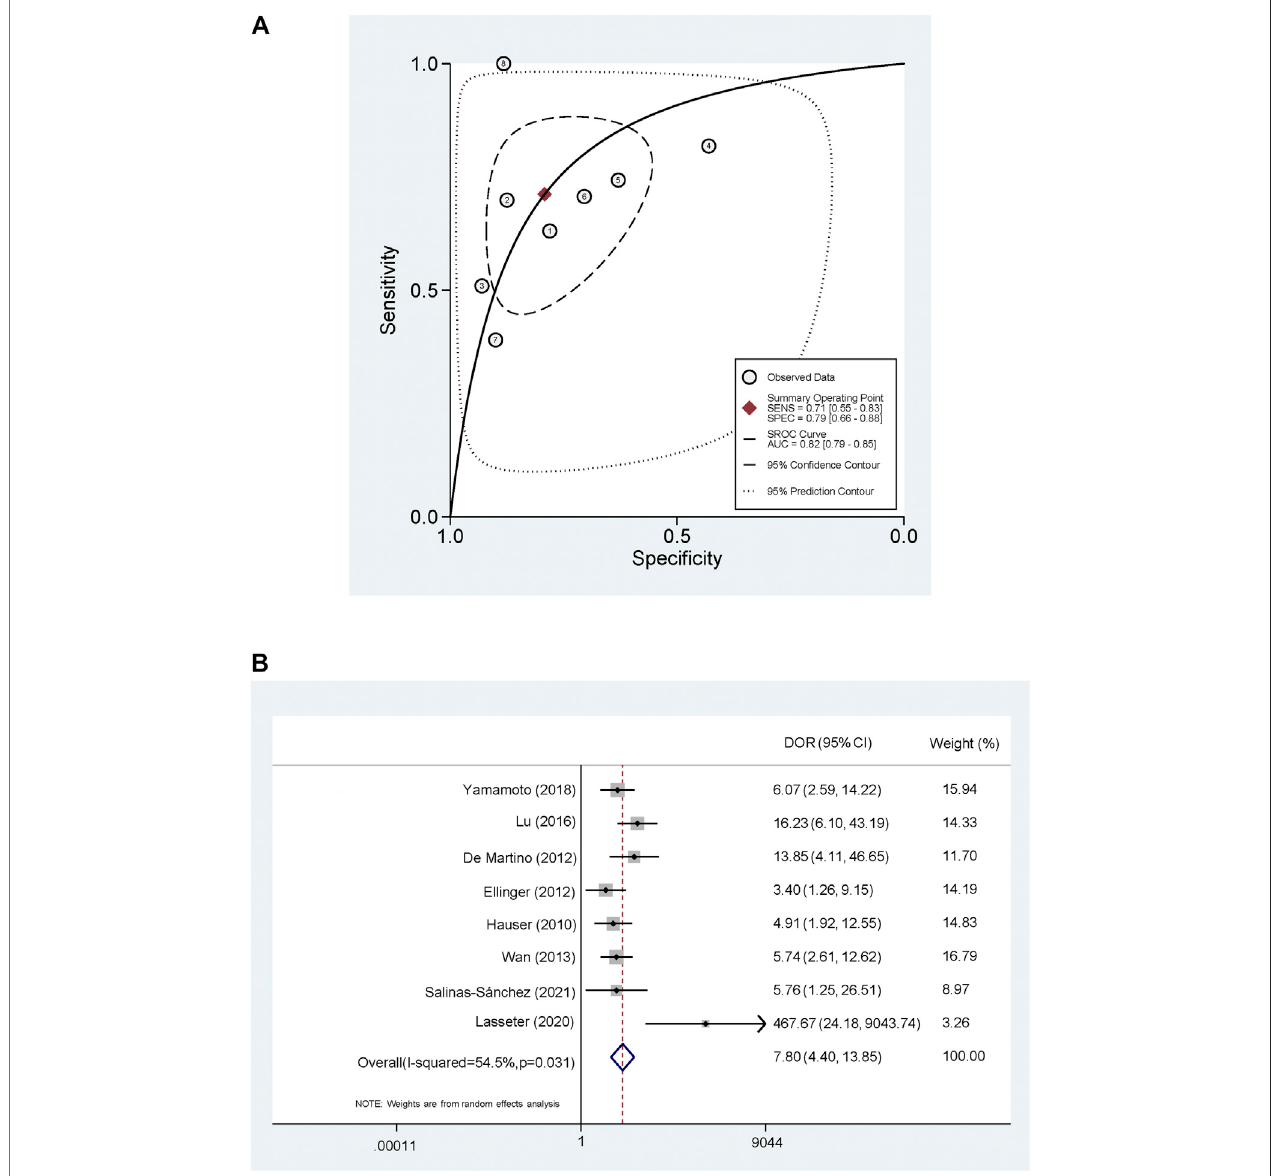
FIGURE 5 | Summary receiver operating characteristic curve and Forest plot of diagnostic odds ratio (A) Summary receiver operating characteristic curve (B) Forest plot of diagnostic odds ratio.